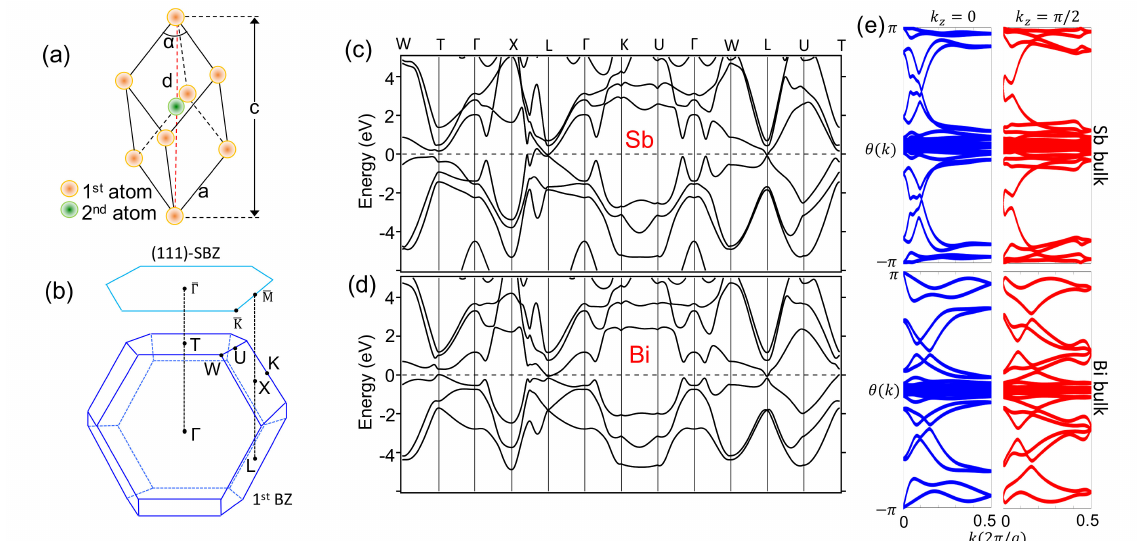
Figure 1. (Color online). ( a ) Rhombohedral crystal lattice of Bi and Sb. ( b ) Bulk Brillouin zone and (111) surface Brillouin zone of Bi and Sb. ( c , d ) Bulk band structure of Bi and Sb, respectively. ( e ) Wannier charge center evolution in time-reversal invariant planes of Bi and